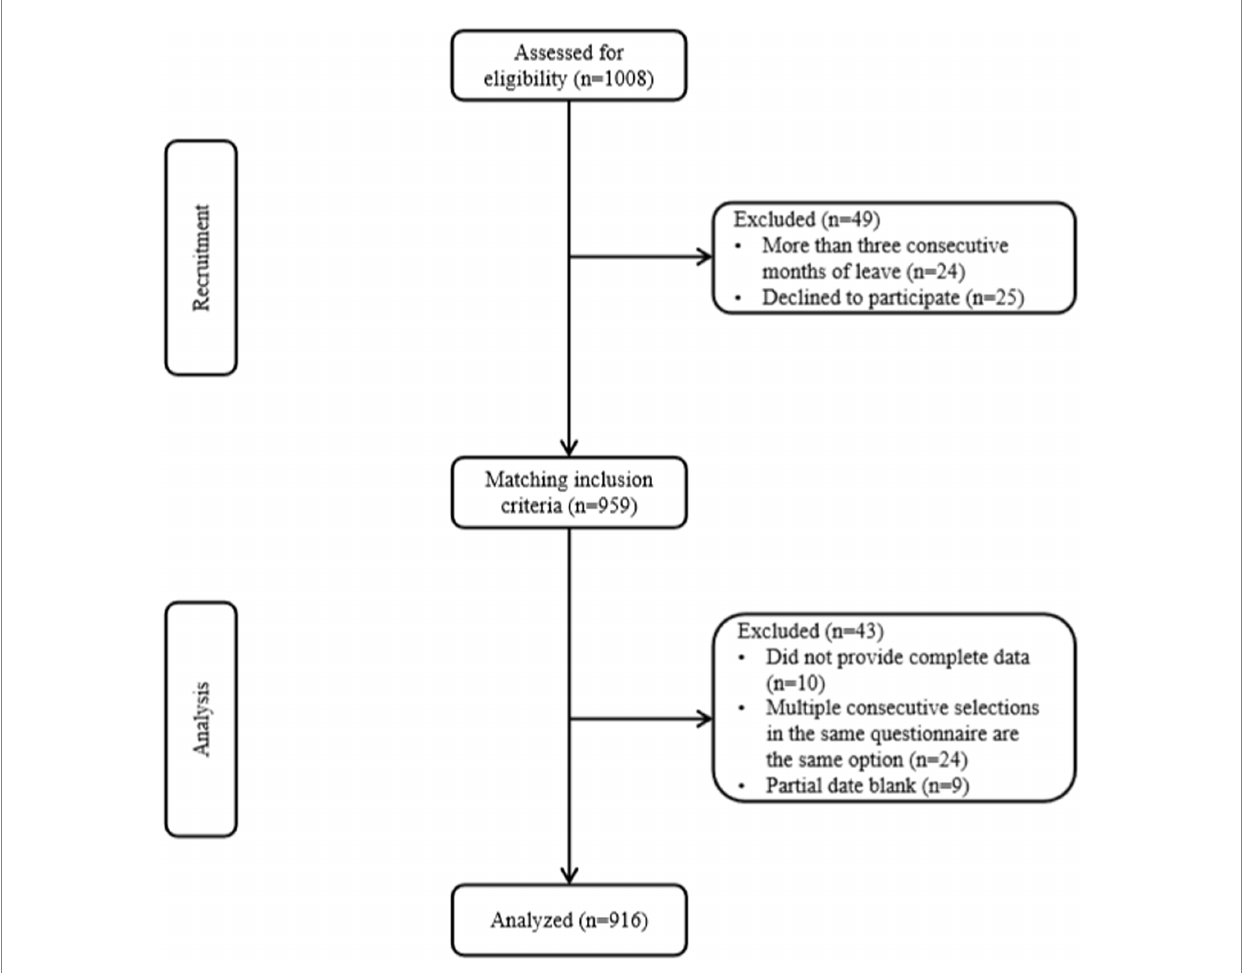
FIGURE 1 Flow chart showing study participants’ recruitment and study selection ( n = 916, Shandong,